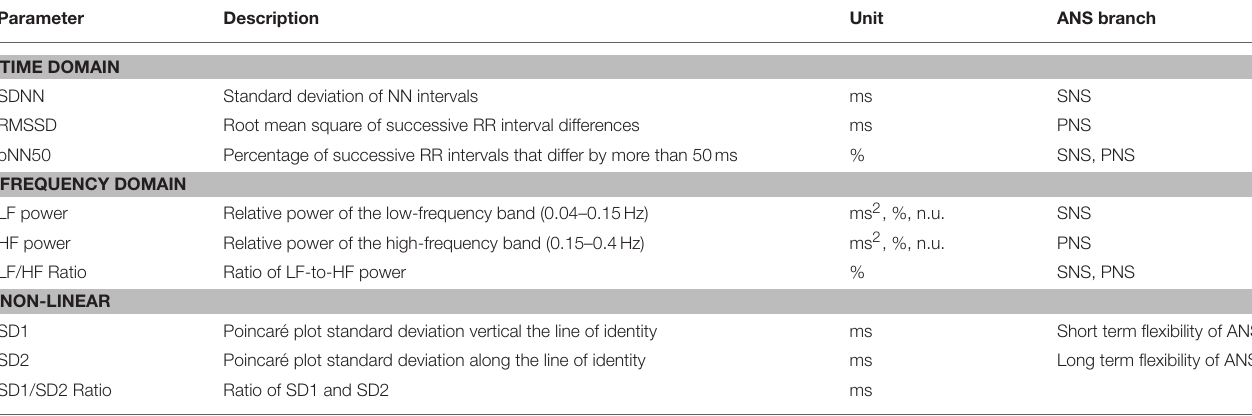
TABLE 1 | HRV parameters derived from time-domain, frequency-domain and non-linear procedures, abbreviations and descriptions.